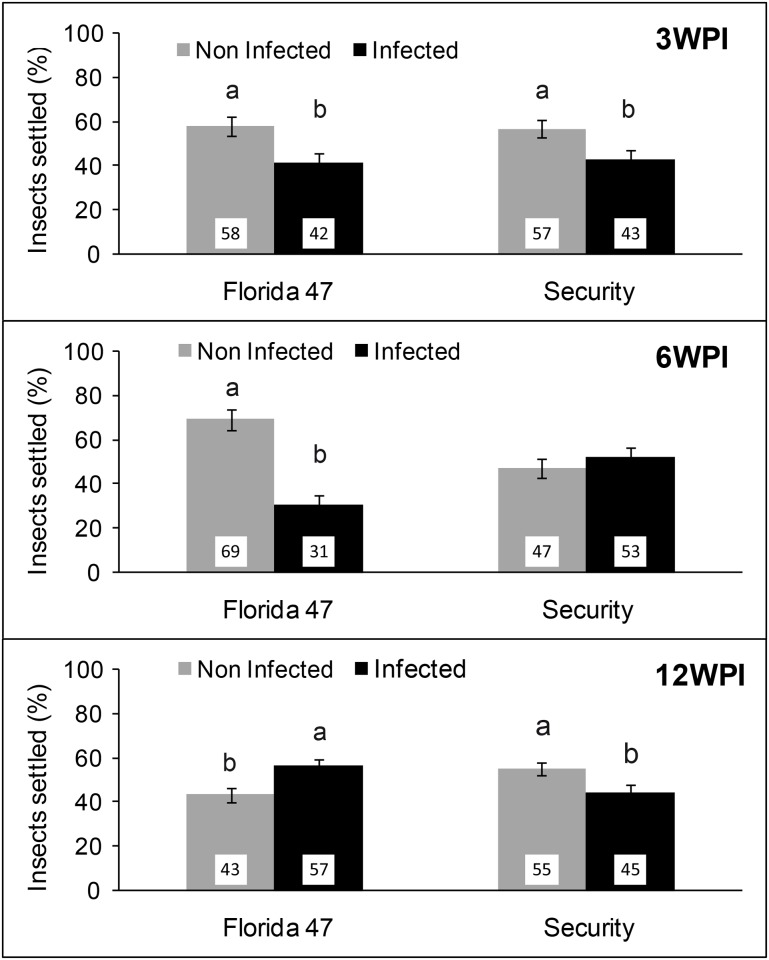
Settling of viruliferous whiteflies (B. tabaci).Bars with standard errors indicate percent settling of viruliferous whiteflies on TYLCV-infected (black bars) or non-infected (grey bars) leaves of a TYLCV-resistant (Security) and a susceptible (Florida 47) genotype 24h post release. Panels show whitefly settling on infected and non-infected plants after 3, 6, and 12 weeks post inoculation, respectively. Different letters indicate significant differences between treatments at α = 0.05 based on least square means.